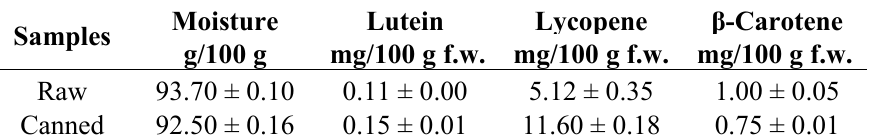
Table 1. Carotenoid contents in raw and canned cherry tomatoes (mg/100g f.w.), values are mean ± standard deviation of three